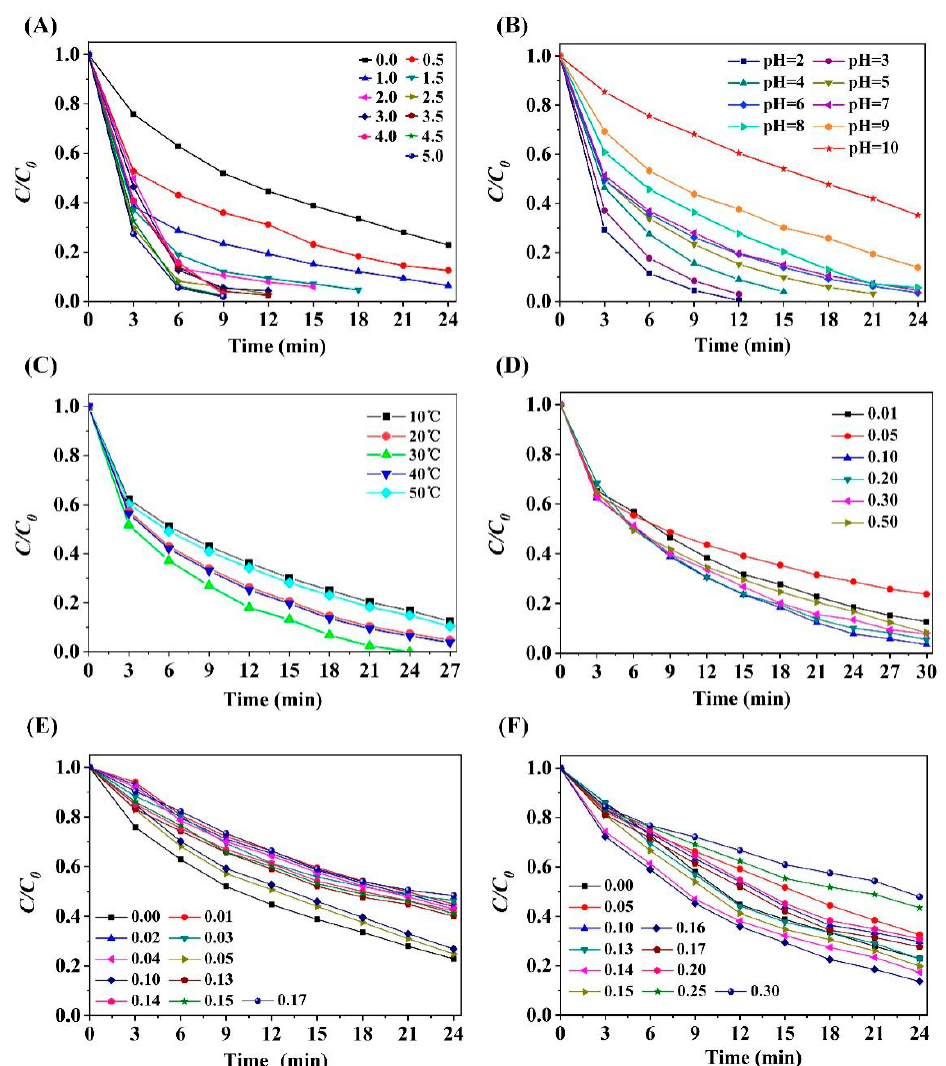
Figure 3. Time-dependent profiles of azophloxine removal under in different conditions: ( A ) Effect of PMS dosage. Reaction conditions: T = 25 °C, pH = 4; ( B ) Effect of initial pH. Reaction conditions: [PMS] = 5 mmol/L, T = 25 °C; ( C ) Effect of reaction temperature; ( D ) Effect of initial NaCl concentration; Concentration unit: mmol/L; ( E ) Effect of initial Na 2 CO 3 concentration. Concentration unit: mmol/L; ( F ) Effect of initial NaHCO 3 concentration. Concentration unit: mmol/L; ( C – F ) Reaction conditions: [PMS] = 5 mmol/L, T = 25 °C, pH = 6. Other chemical reagents used: [FeAlg-ACF] = 2 g/L, [azophloxine] = 50 μ mol/L.